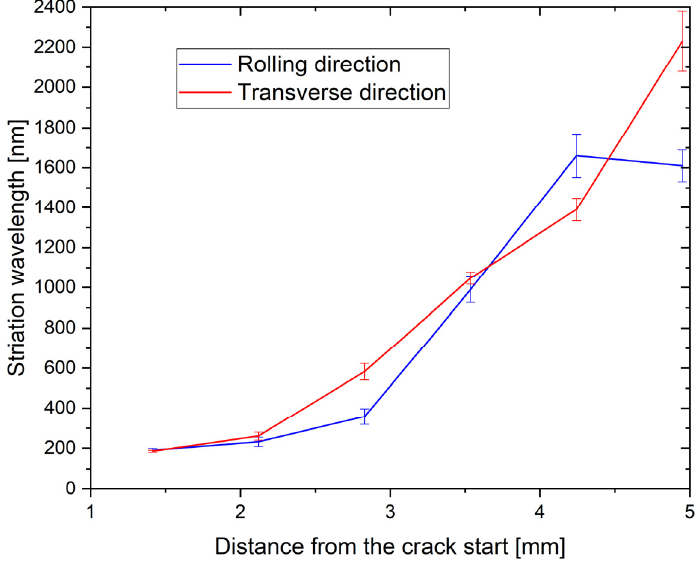
Figure 13. Striation wavelength in dependence from the crack start (RD—sample, TD—sample).